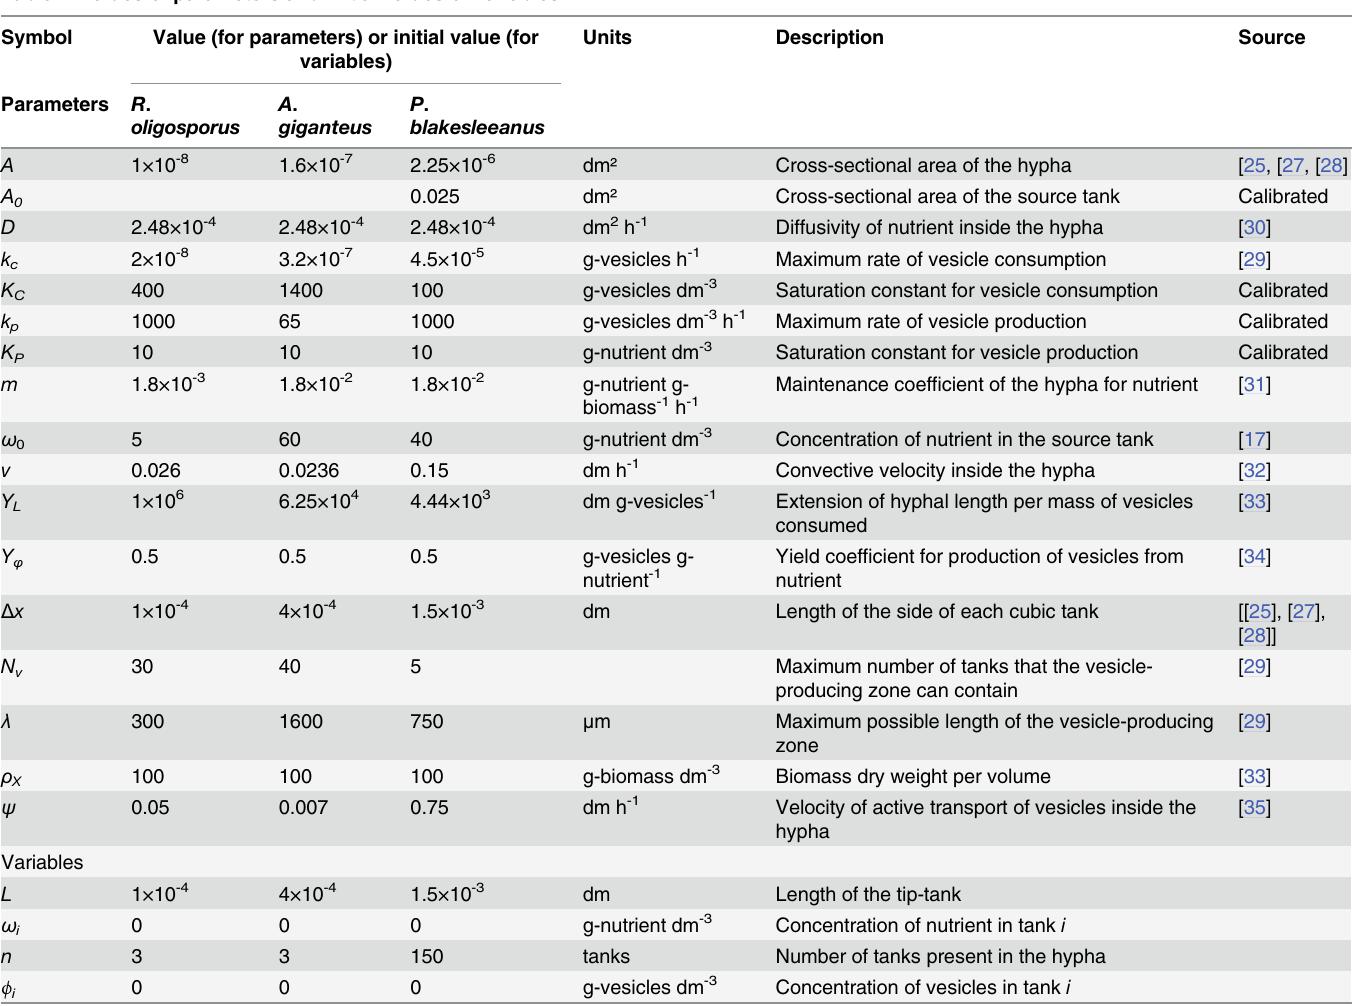
Table 1. Values of parameters and initial values of variables. Symbol Value (for parameters) or initial value (for